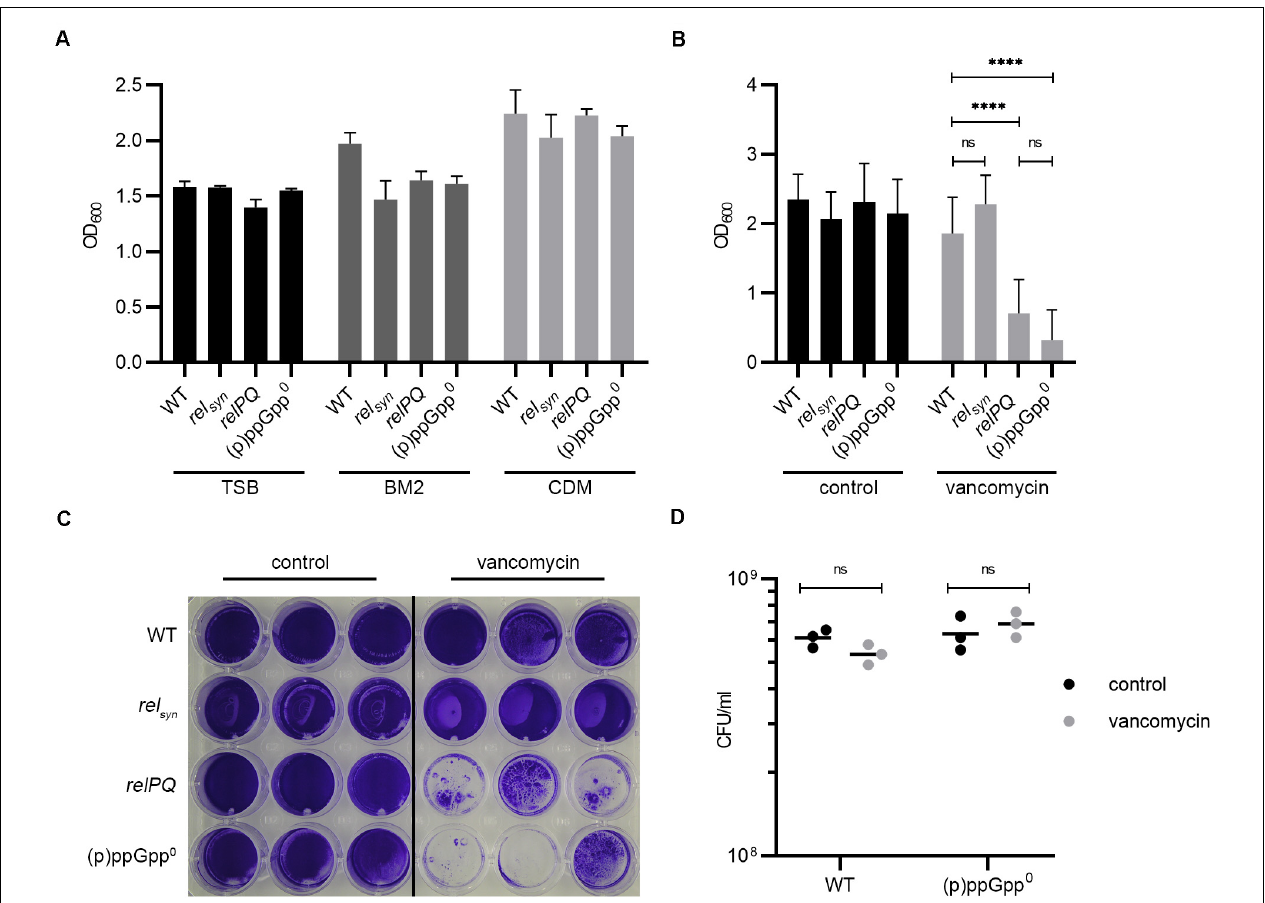
FIGURE 1 | (p)ppGpp synthases effect biofilm formation under cell wall stress conditions. (A) Biofilm formation in TSB (+3% NaCl, +0.5% glucose), BM2 and CDM after 24 h. (B) Biofilm formation under uninduced and vancomycin-stress (subinhibitory vancomycin 0.78 µ g/ml) conditions in CDM after 24 h. Three separate experiments were performed with biological triplicates each. Error bars represent the standard deviation, statistical significance based on ordinary one-way ANOVA (ns: not significant, ****: P < 0.0001). (C) Representative plate stained with crystal violet. (D) CFU was determined from resolved biofilm and planktonic bacteria after 24 h of static